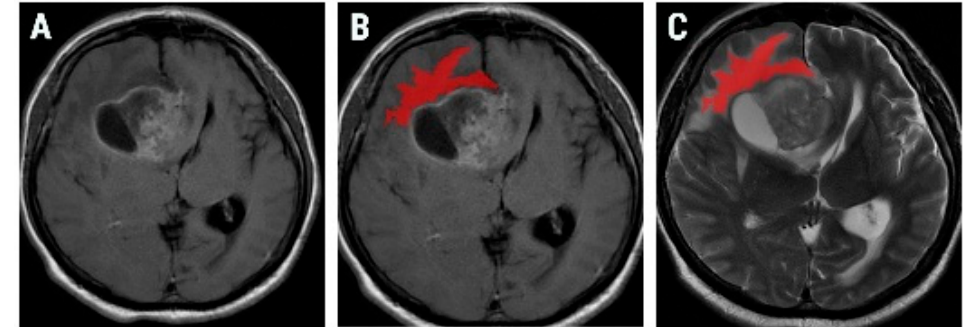
Figure 2. Axial contrast-enhanced T1-weighted image of a 56-year-old patient with pathologically proven glioblastoma ( A ) and the region of interest (red) overlapping the peritumoral area ( B ) on a postcontrast T1-weighted image, which was consequentially transferred on to a synchronized slice on the T2-weighted sequence ( C ).